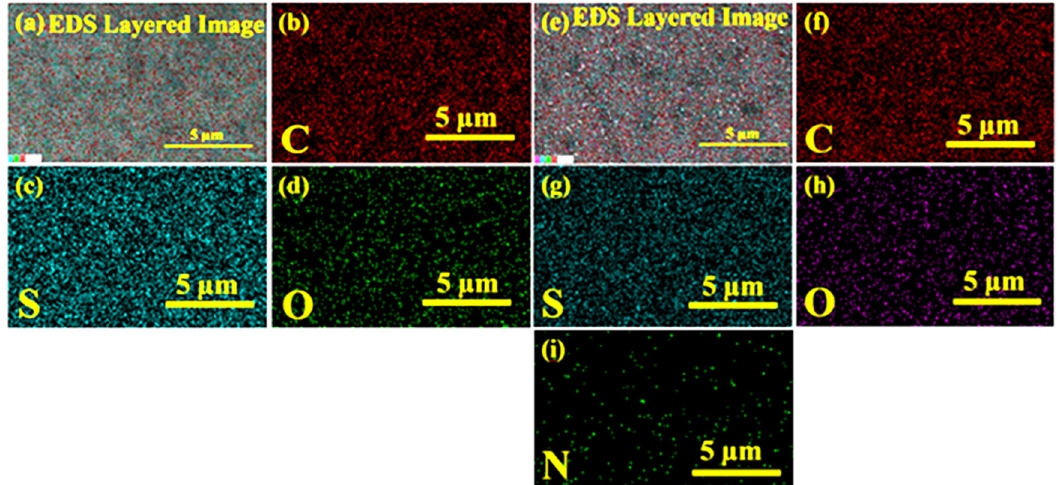
Fig. 4 Elemental analysis of the membranes. a – d Elemental mapping analysis of the PS/PET support for the Carbon (C), Sulfur (S), and Oxygen (O) and e – i Elemental mapping analysis of the HCPA-TFC-NF@M2 membrane for the Carbon (C), Sulfur (S), Oxygen (O), and Nitrogen